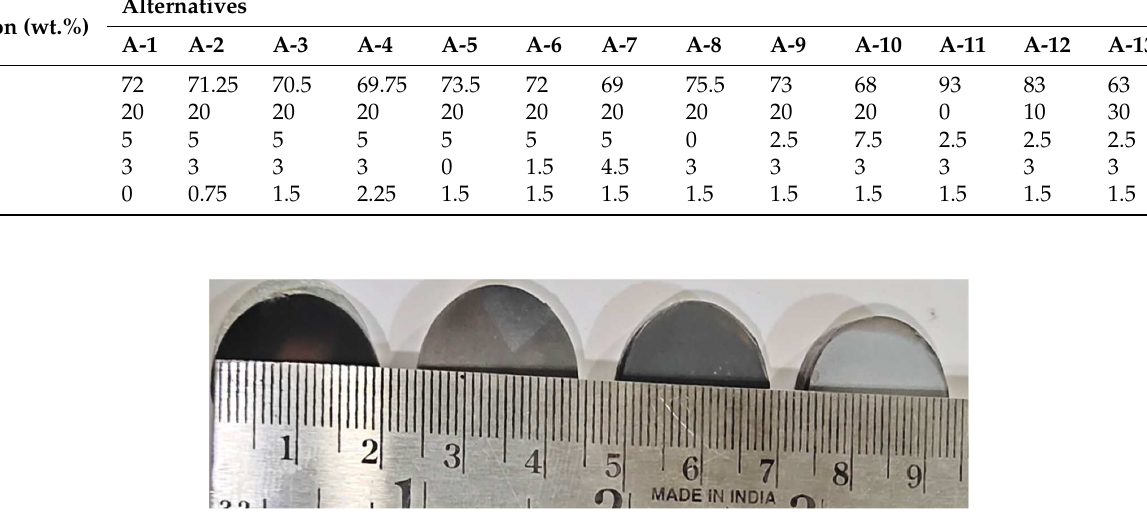
Table 1. Compositional detail of hip implant composite alternatives.